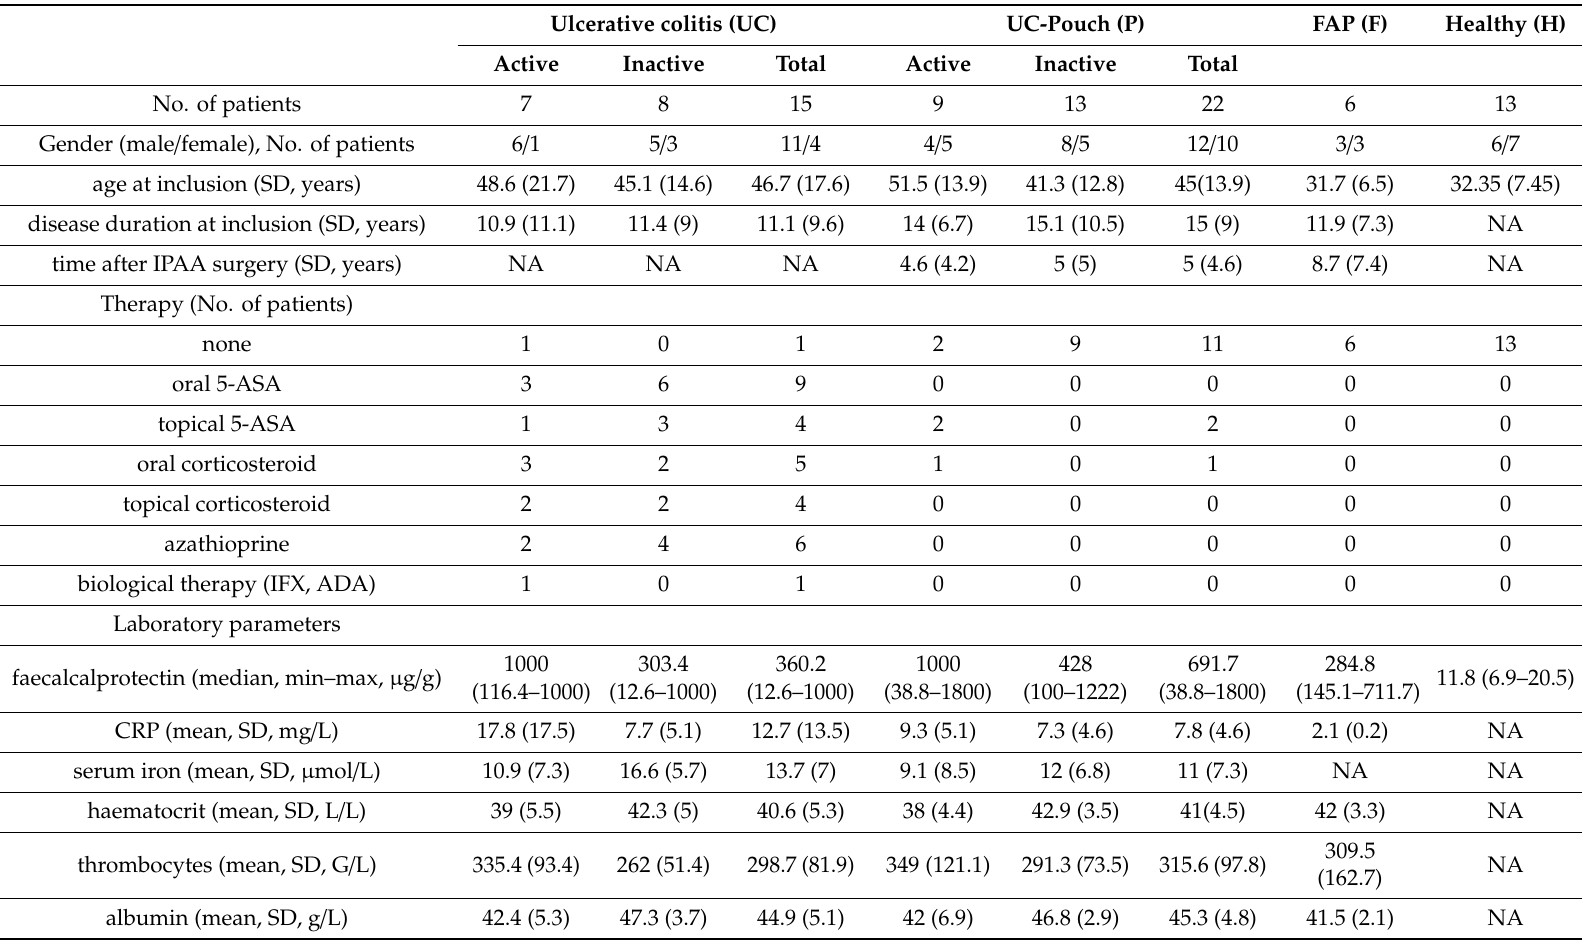
Table 1. Patients’ demographic, clinical and biochemical